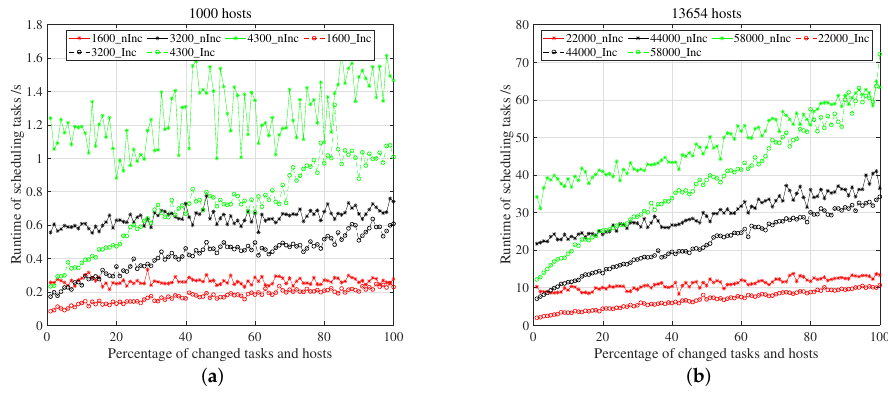
Figure 9. Runtime of scheduling tasks. ( a ) 1000 hosts. ( b ) 13,654 hosts.